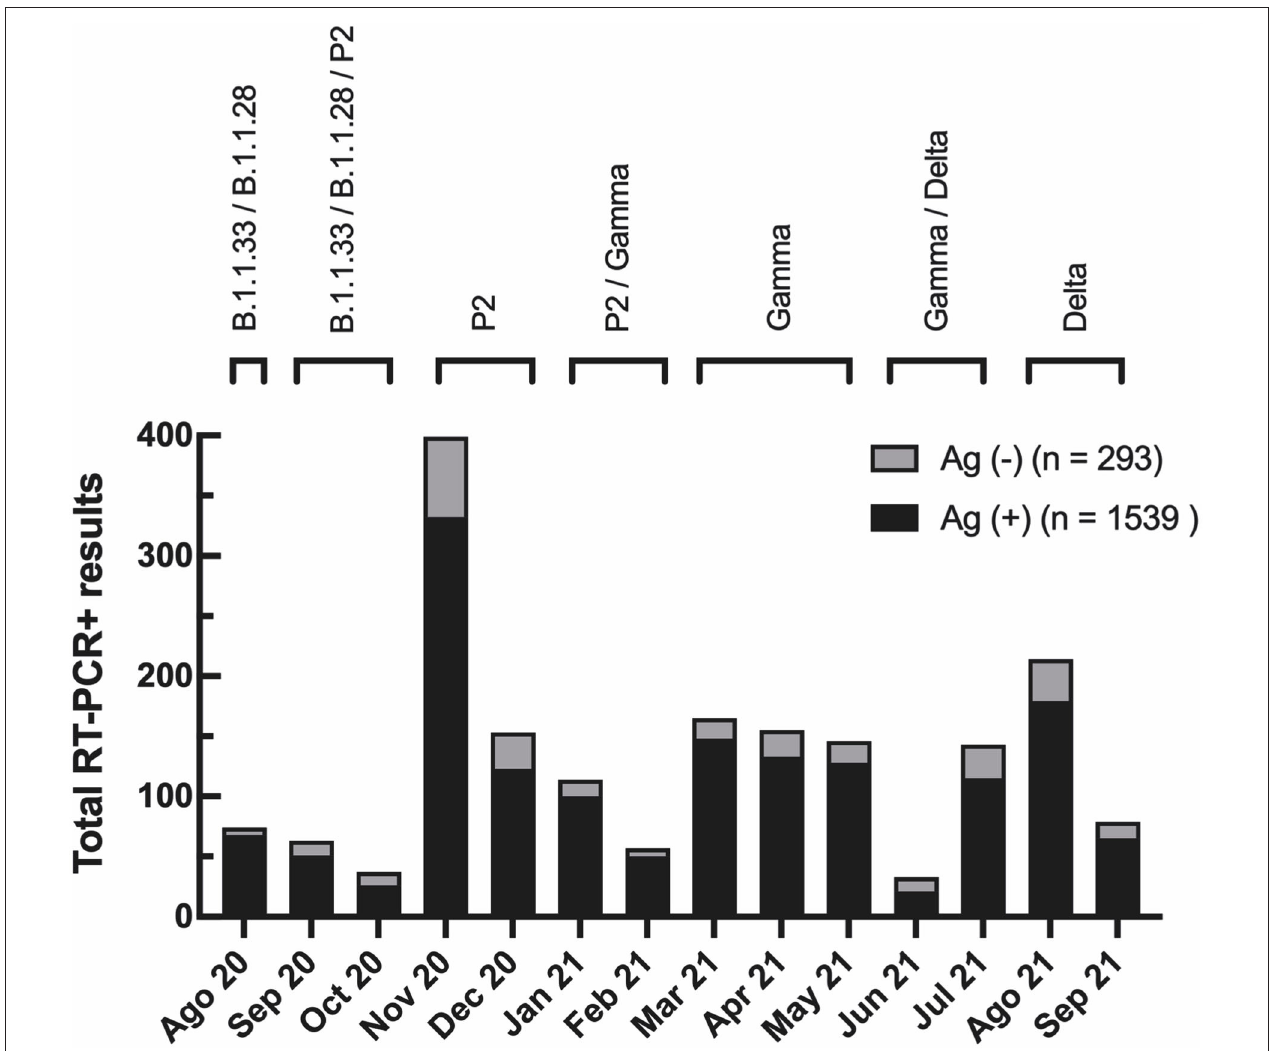
FIGURE 2 | Evaluation of Panbio TM COVID-19 Antigen RDT test showed low false-negative occurrence with no variation during the time of the study. The total number of RT-PCR positive results per month in the studied population. In black, the total number of RT-PCR positive individuals with a negative antigen [Ag (–)] RDT result (discordant group). In gray, the total number of RT-PCR positive individuals with a positive Antigen [Ag ( + )] RDT result (concordant group). At the top, prevalent viral variants in Rio de Janeiro state during the study, according to data from the Vigilance Network of the State of Rio de Janeiro